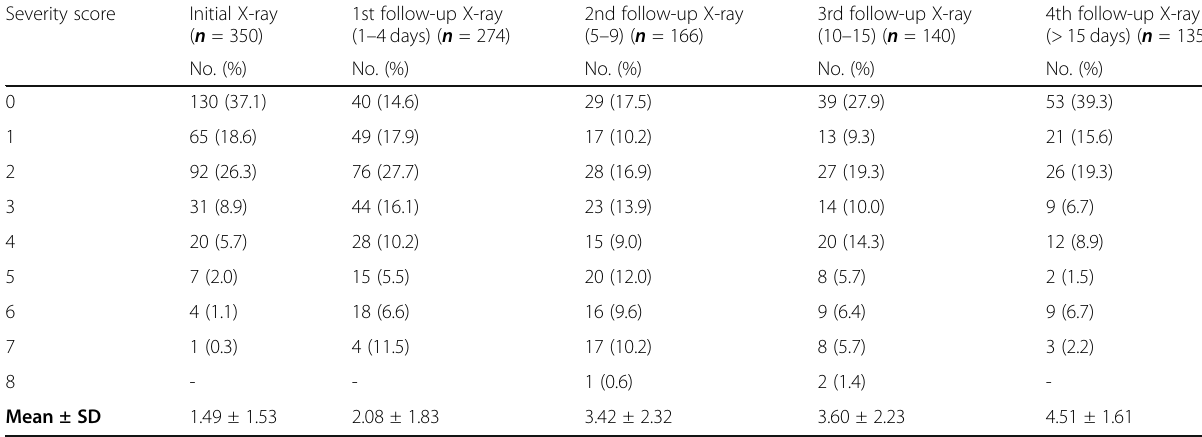
Table 3 CXRs severity score at different stages Severity